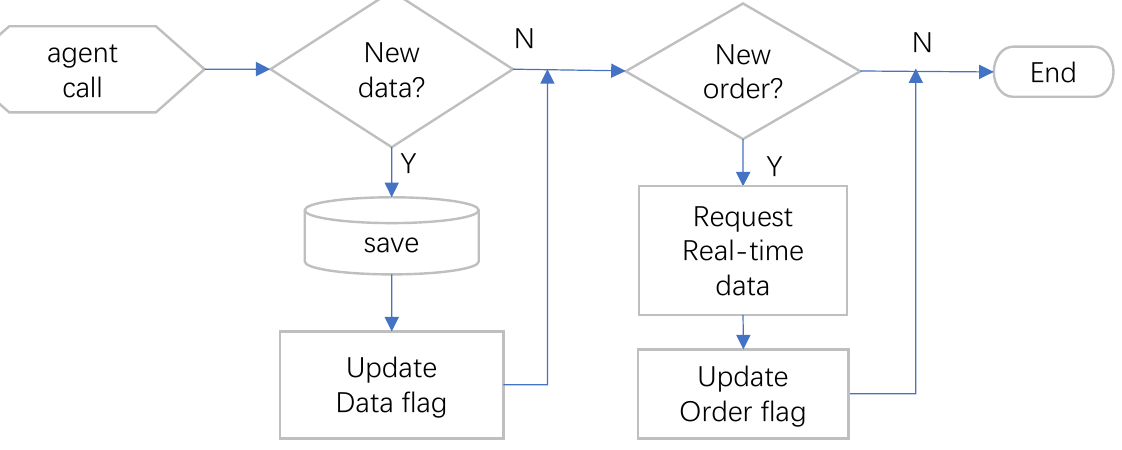
Figure 10. The data flow of the daemon responding to agent call.